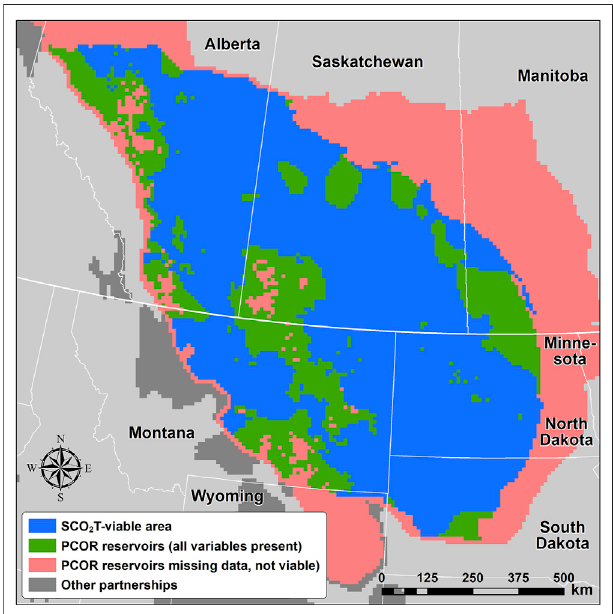
FIGURE 1 | Geographic Area Used in This Study. Image taken from Ogland-Hand et al.